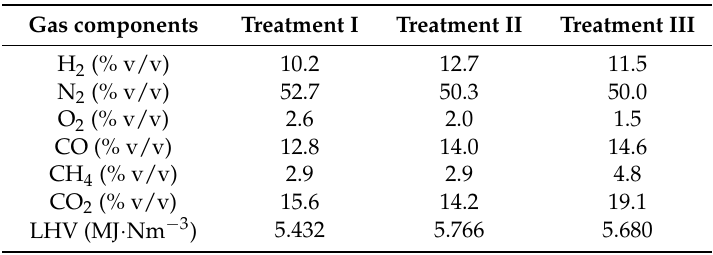
Table 4. Syngas composition and heating value for the three cleaning treatments.